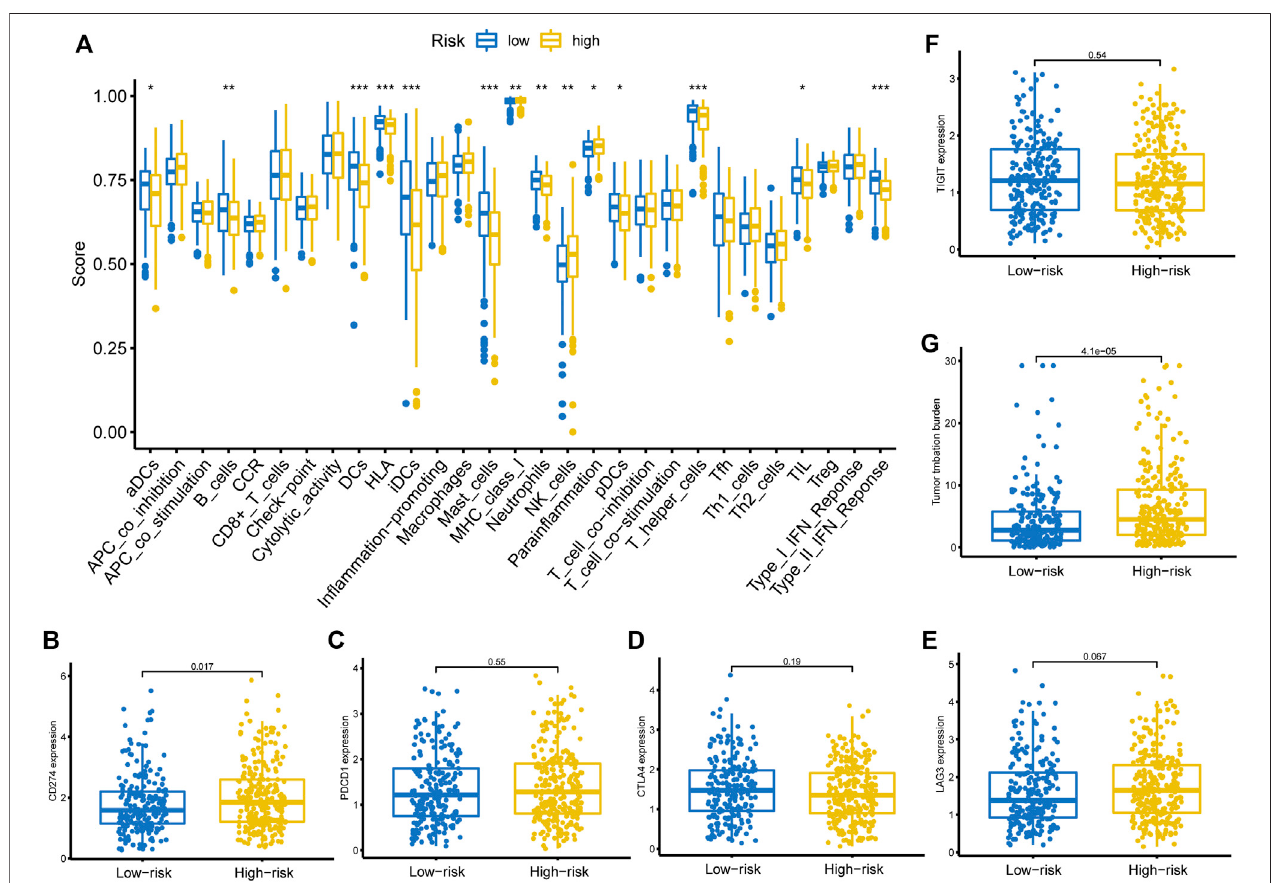
FIGURE7| Immunefunction,ICIsrelatedgenesexpressionpattern,andTMBbetweendifferentriskgroups. (A) Immunecellsin fi ltrationscoreandimmune-related pathways activity in the low- and high-risk groups estimated by ssGSEA. (B – F) The correlation between the risk score and the expression level of CD274 , PDCD1 , CTLA4 , LAG3 , and TIGIT . (G) The relationship between the risk score and TMB. ICIs, immune checkpoint inhibitors; TMB, tumor mutation burden, ssGSEA, single- sample gene set enrichment analysis.